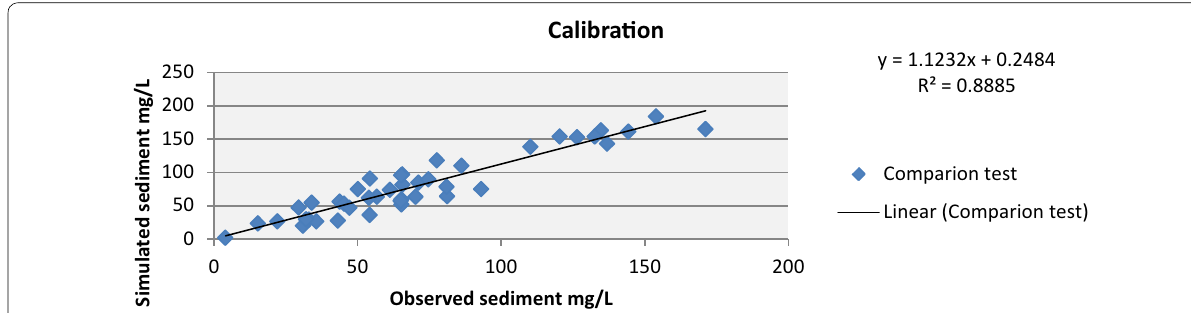
Fig. 7 Observed verse simulated to sediment during calibration